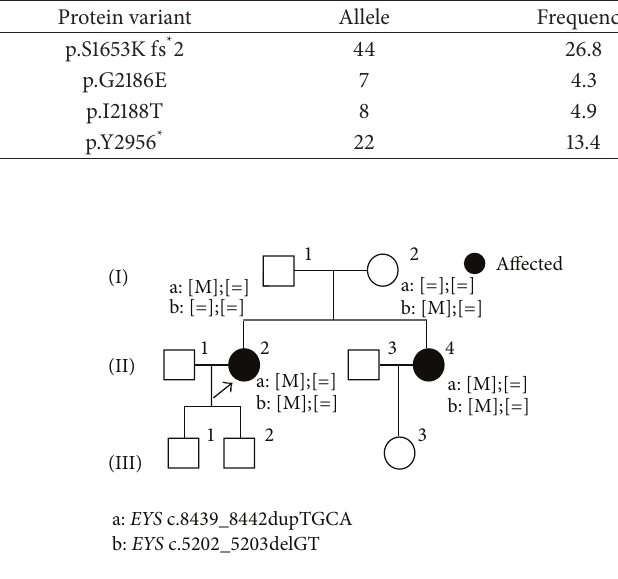
Figure 5: A pedigree of arRP with novel EYS mutations. A family carrying two novel EYS mutations, c.8439 8442dupTGCA (a) and c.5202 5203delGT (b), is presented. Affected II-2 and II- 4 carried compound heterozygous mutations. I-1 carried a het- erozygous c.8439 8442dupTGCA mutation and I-2 did another c.5202 5203delGT heterozygous mutation. Affected individuals are indicated as filled symbols, and an arrow indicates the proband in this